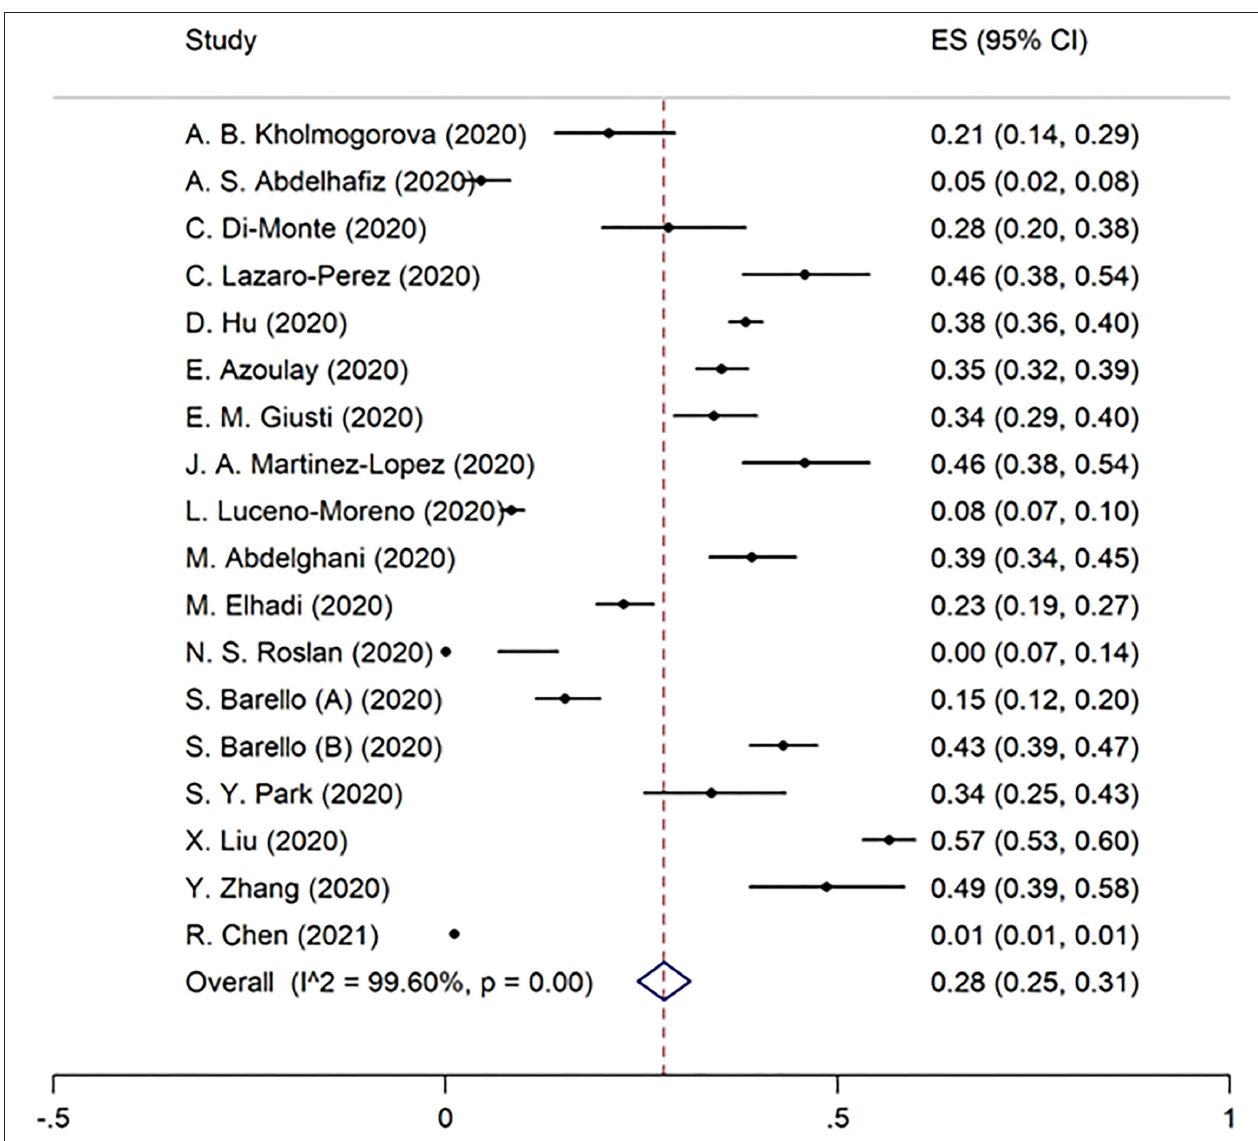
FIGURE 3 | The pooled prevalence of emotional exhaustion in included studies.